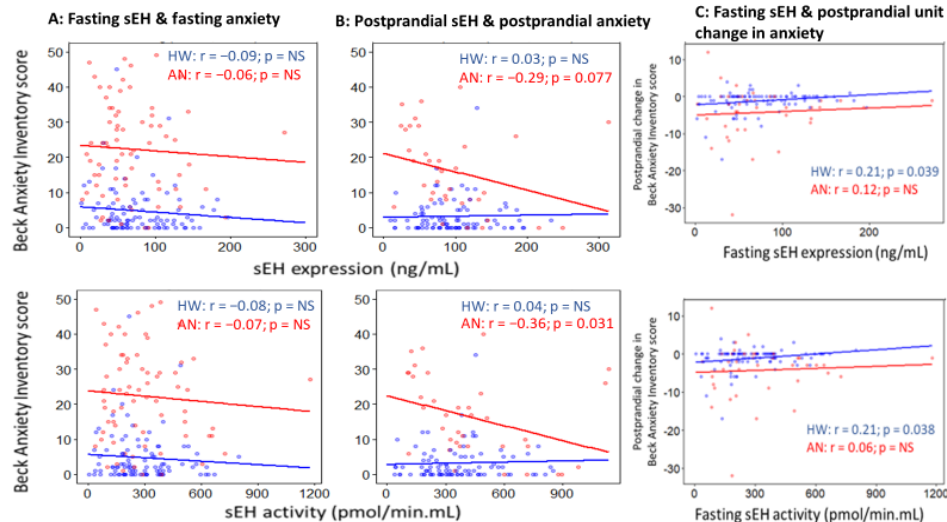
Figure 7. Scatterplots for Pearson’s correlations of sEH expression (top) and activity (bottom) with Beck Anxiety Score at ( A ) fasting and ( B ) postprandial timepoints in healthy women (blue) and women with anorexia nervosa (red). Scatterplots for Pearson’s correlations of sEH expression (top) and activity (bottom) with postprandial unit change in Beck Anxiety Score are presented in ( C ). Colored dots and solid lines represent individual data points and slopes of the examined relationships, respectively. r and p indicate Pearson’s correlation coefficient and p value, respectively. HW: healthy women; AN: anorexia nervosa; NS: non-significant, p value ≥